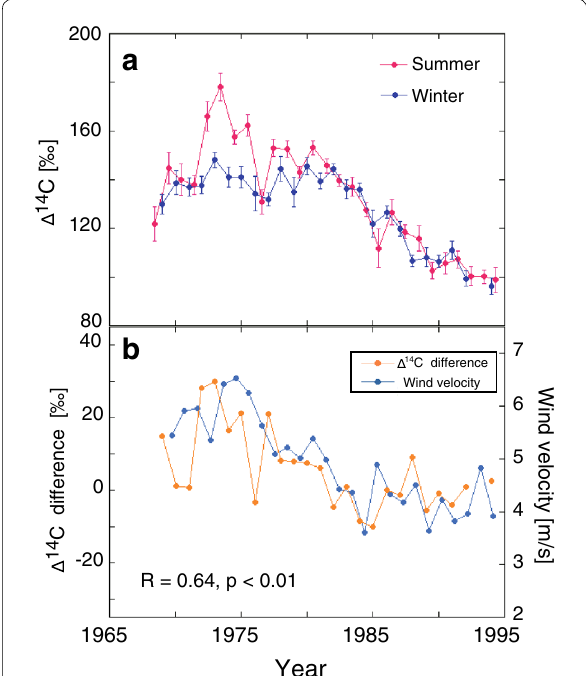
Fig. 3 a Seasonal Δ 14 C of Currimao coral. b Comparison of seasonal Δ 14 C difference of Currimao coral and the average winter monsoon wind velocity from December to February reported in Song et al.